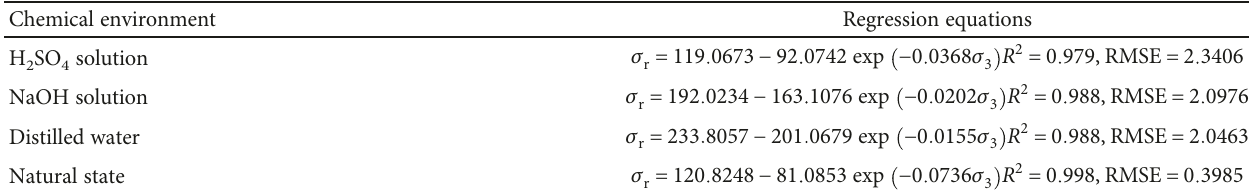
Figure 4: Residual strength at various con fi ning pressures of sandstone specimens treated with di ff erent chemical corrosions. The chemical environment is (a) H SO solution, (b) NaOH solution, (c) distilled water, and (d) natural state. 2 4 Table 4: Regression results of residual strength at various con fi ning pressures.